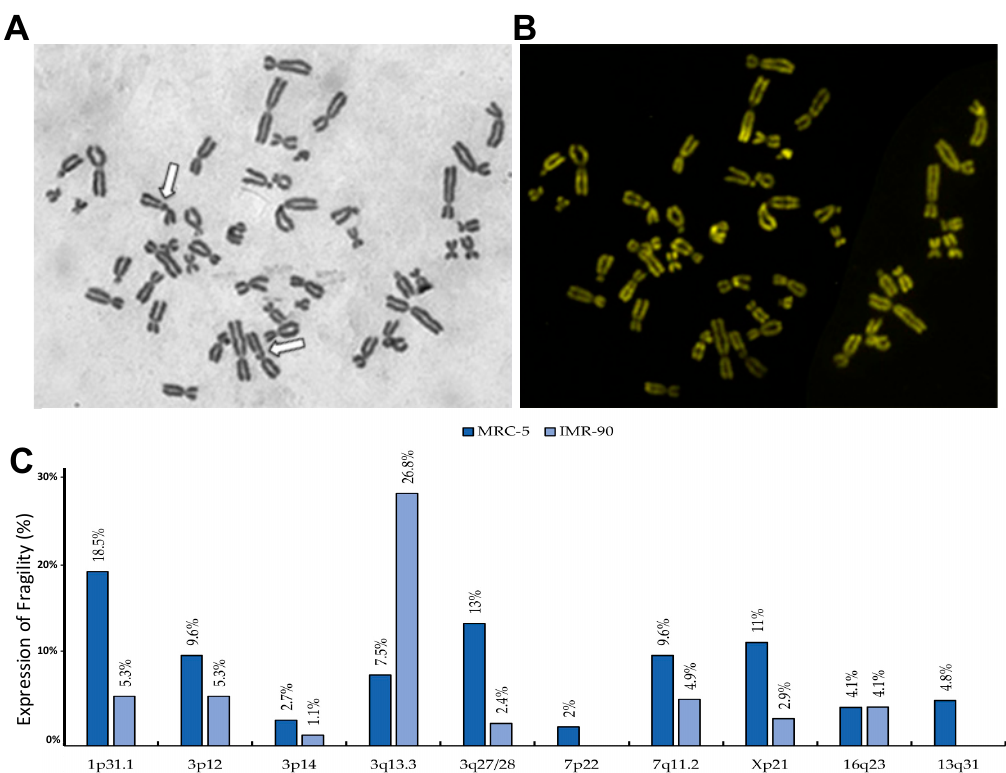
Figure 1. Cytogenetic localization and expression of common fragile sites in fibroblast cell lines. ( A ) IMR-90 metaphase stained with Giemsa. The white arrow shows the break on chromosomes 3 (3q13.3). ( B ) The same sample stained with CMA3 for more precise localization by banding. ( C ) The histogram showing the percentage of breaks expressed in both MRC-5 and IMR-90 cell lines as an average of three experiments; the breaks with frequency lower than 3% were not considered, given their uncommon fragility.